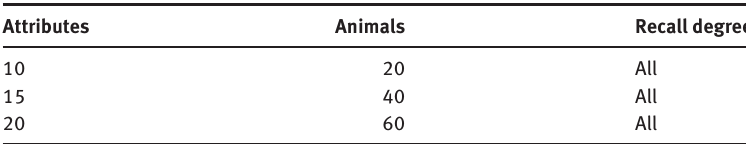
Table 6: Results of PLDNN Representing and Memorizing Logical Relations.